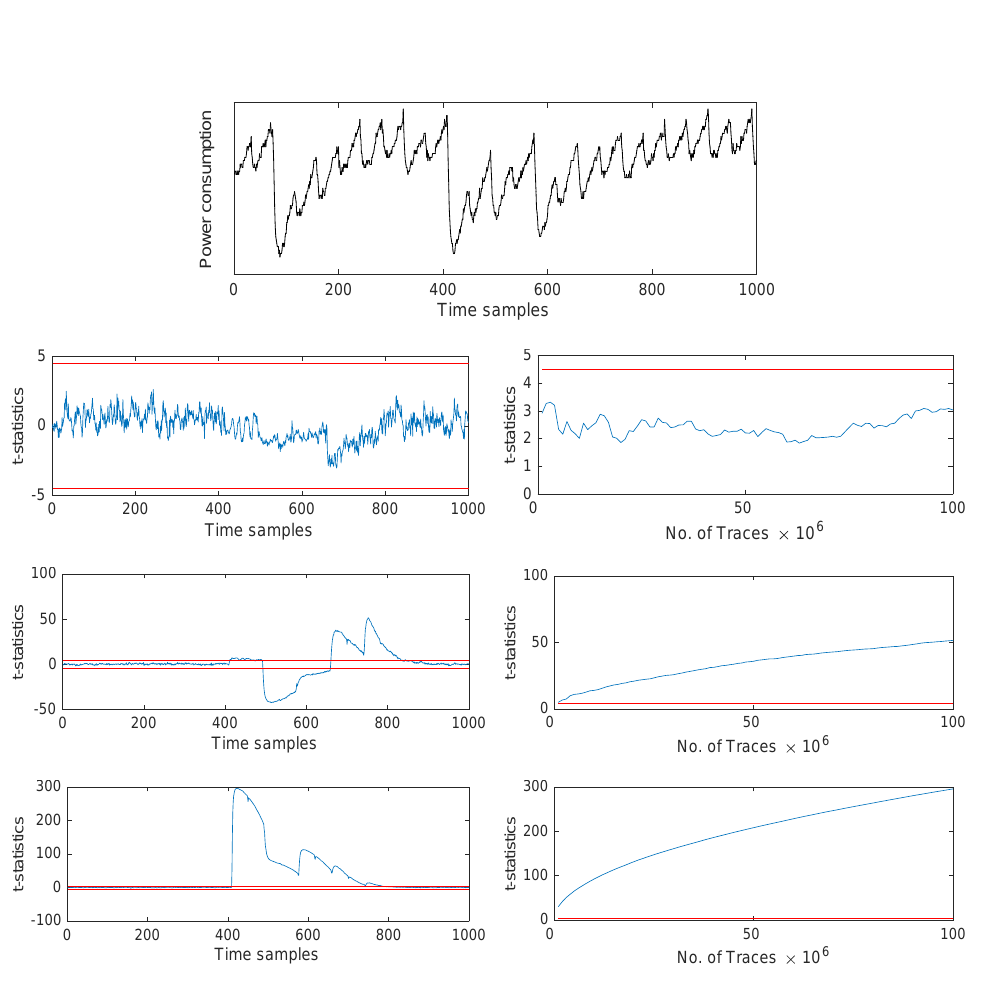
Figure 19: Sample power trace and univariate non-specific t -test results with 100 million measurements for two composed DOM- indep multiplications ( d = 2) based on GF (2 4 ) multipliers with output registers but without pipeline registers applied. The second to fourth row show the t -statistics for the statistical moments 1 to